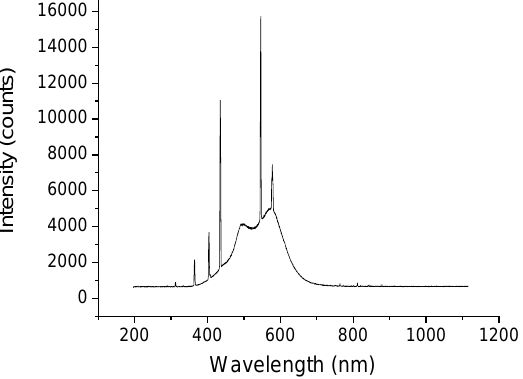
Figure 2. Emission spectrum of custom-built photochemical